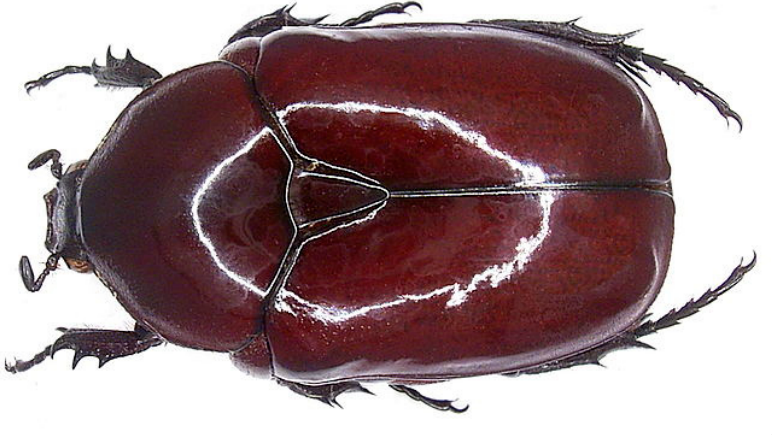
Figure 4. The feared scarab beetle Diplognatha gagates (Cetoniinae) in Mali. (https://commons.wikimedia.org/wiki/File:Diplognatha_gagates_Forster,_1771_(3232045262).jpg). Attribution: Udo Schmidt from Deutschland, CC BY-SA 2.0, via Wikimedia Commons. (Accessed 20 April 2021)